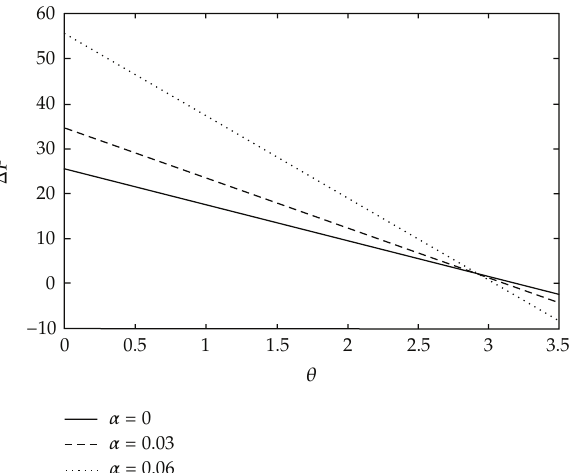
Figure 1: The pressure rise versus flow rate when a (cid:9) 0 . 2 ,b (cid:9) 0 . 6, d (cid:9) 0 . 8 , ε (cid:9) 0 . 3 , λ 1 (cid:9) 0 . 8 , Da (cid:9) 0 . 6, and φ (cid:9) π/ 4.